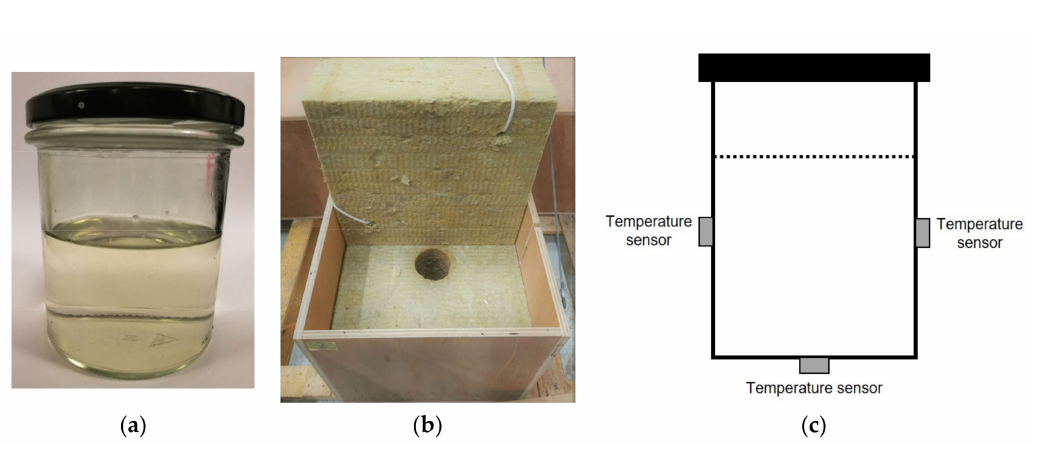
DTU Heat Loss Method